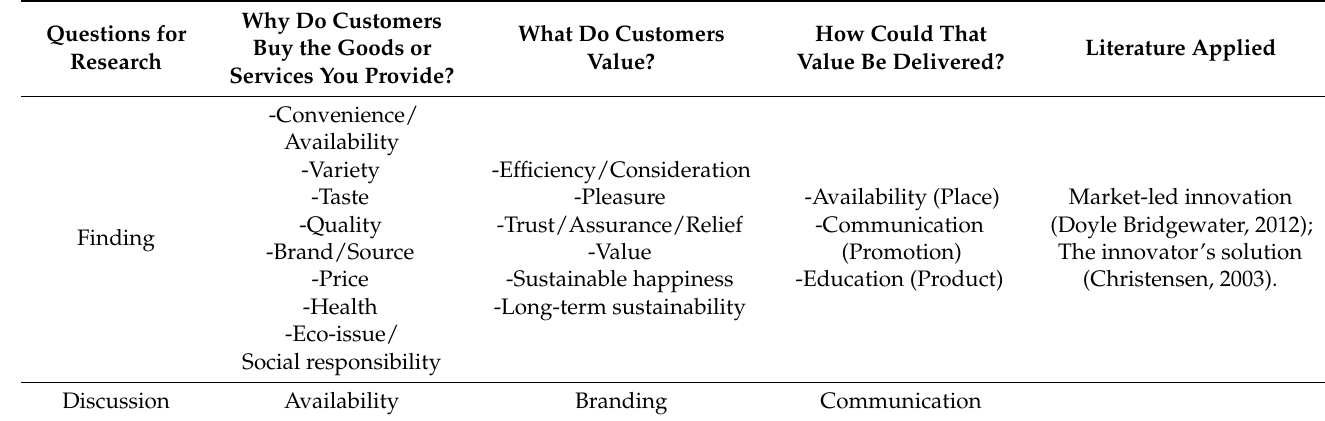
Table 5. Factors affecting consumers purchasing decisions.